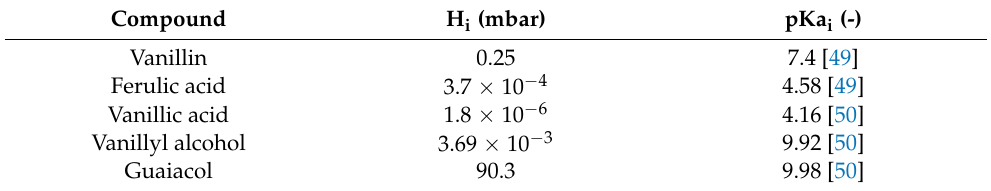
Table 5. Henry constant and pKa of compounds commonly present in a vanillin bioconversion broth at 25 ◦ C.